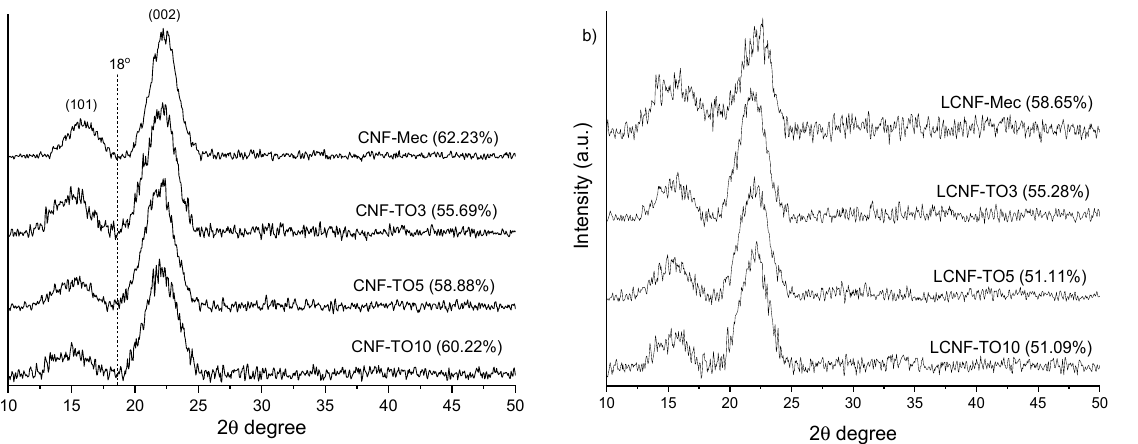
Figure 2. XRD patterns and crystallinity index for lignocellulosic nanofibers (LCNF) ( a ), and for cellulose nanofibers (CNF) ( b cellulose nanofibers (CNF) ( b ).